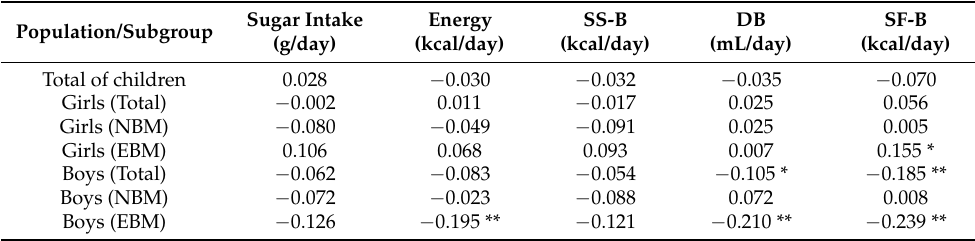
Table 3. Correlations between BMI Z-score with sugar intake, energy, sugar-sweetened, dairy, and sugar-free